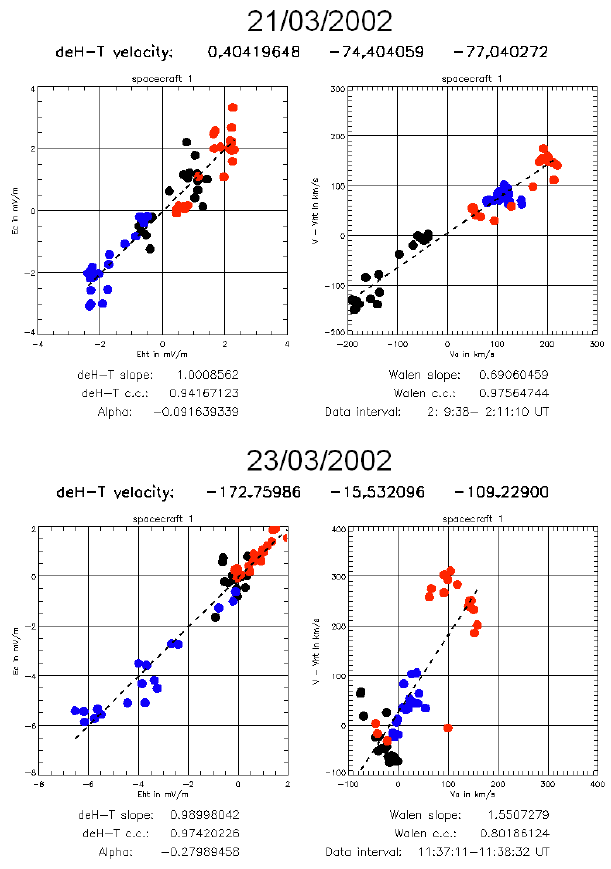
Figure 7. Scatter plots of the deH-T analysis and Walén tests for the two 21/03/2002 and 23/03/2002 events (GSM coordinates). The Walén test for the 23/03/2002 event totally fails, possibly owing to the Fig. 7. Scatter plots of the deH-T analysis and Wal´en tests for the high solar wind pressure increase monitored by ACE at that time. two 21/03/2002 and 23/03/2002 events (GSM coordinates). The Wal´en test for the 23/03/2002 event totally fails, possibly owing to the high solar wind pressure increase monitored by ACE at that